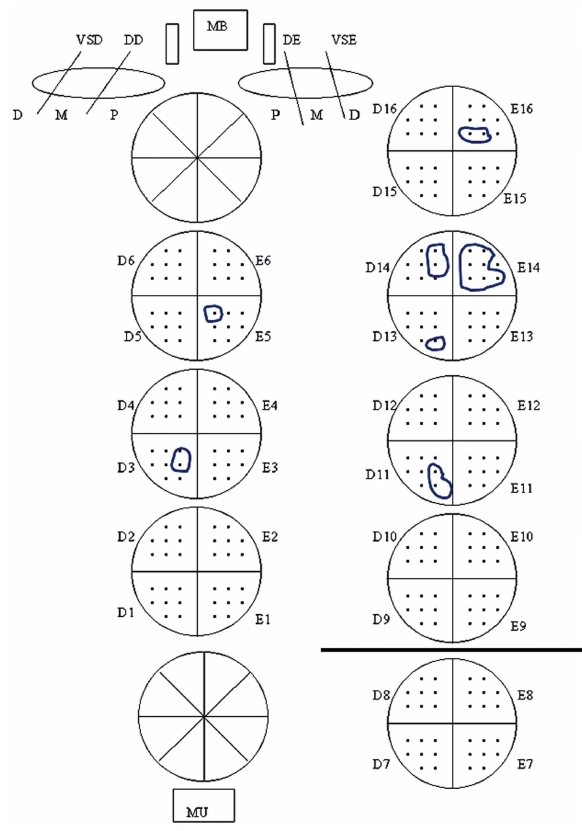
figure 1 - semiquantitative point-count method to evaluate tumor extent. In this case total tumor extent was recorded as 17 positive points. Quadrant E14 shows largest single cancer focus or dominant nodule of all quadrants, recorded as 7 index tumor positive points. The tumor is predominantly basal (located in one quadrant of the upper half of the prostate). The horizontal line divides the prostate in quadrants located in upper and lower half of the